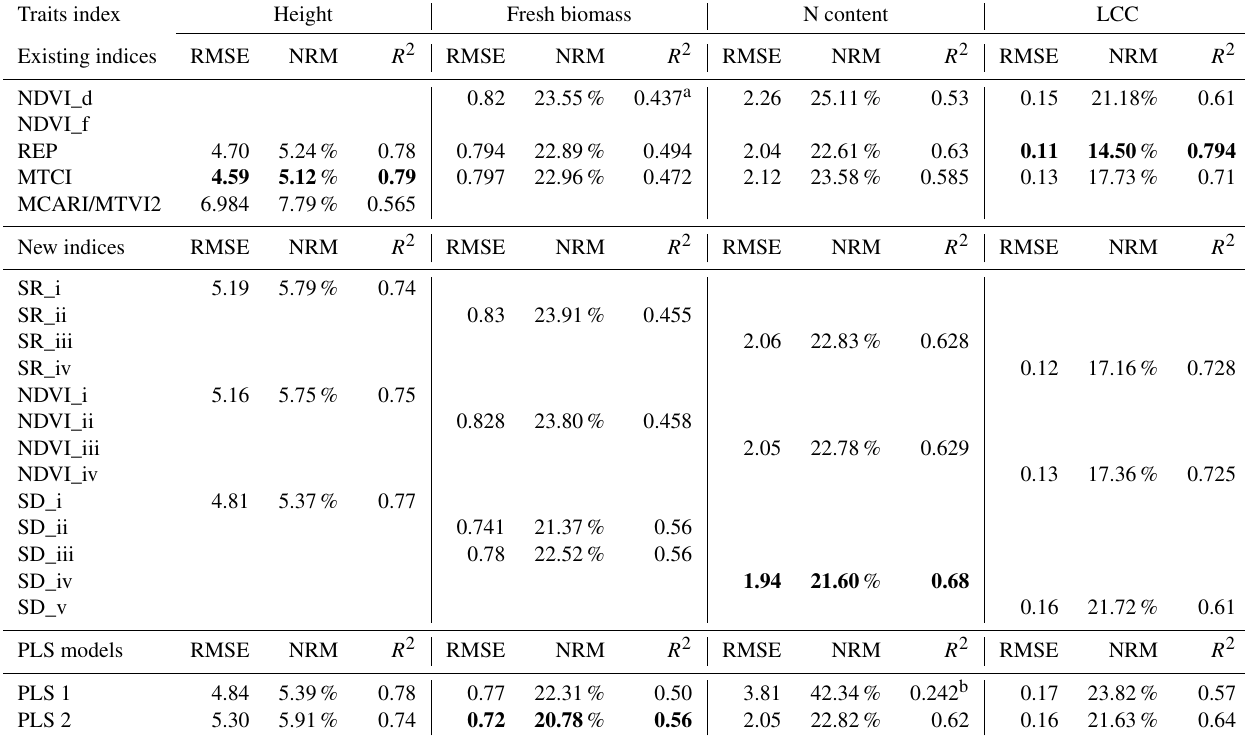
Table 7. Overview of validation statistics for the best selected existing and new indices and both PLS models for the different plant traits, LCC = leaf chlorophyll content. All results presented are significant at < 0.0001 probability level, unless the asterisks indicate otherwise ( a < 0.001, b < 0.1). For each trait the model with the highest predictive accuracy is displayed in bold. Abbreviations: RMSE, root mean square error; NRM, normalized root mean square error; and R 2 , coefficient of determination. Empty cells indicate indices that were not validated as only the best performing indices per trait in the calibration were selected for